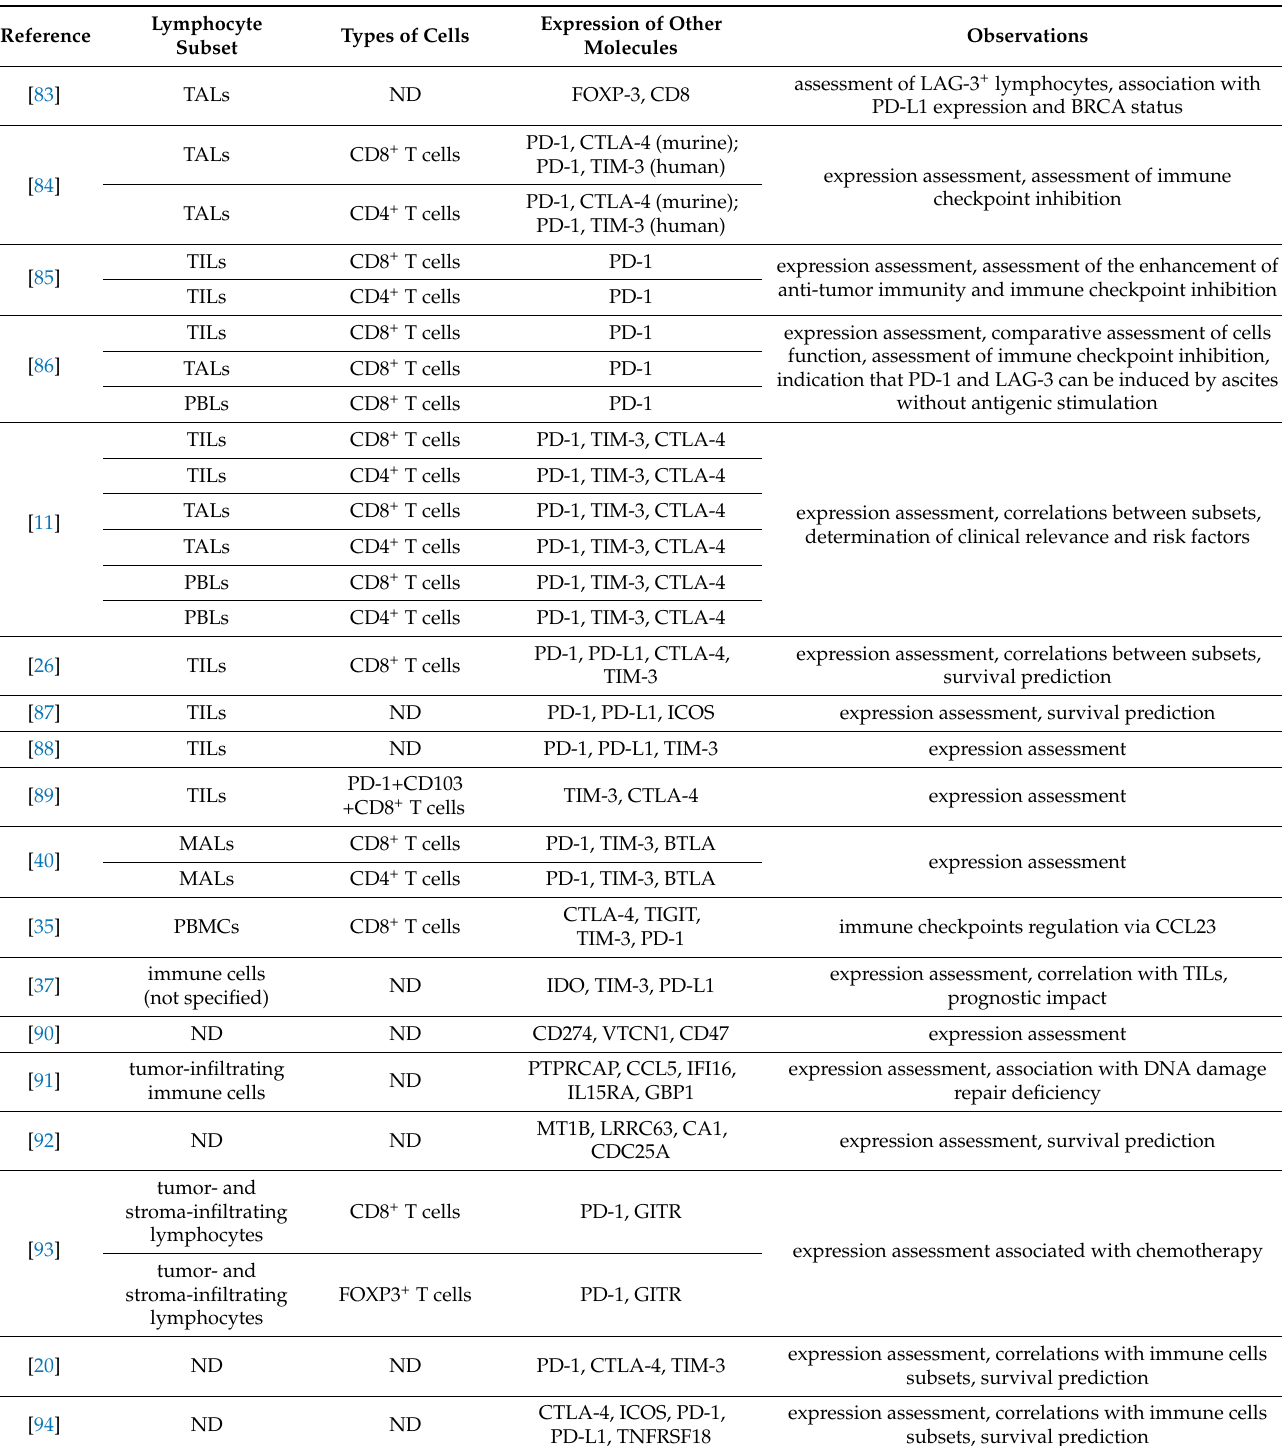
Table 3. LAG-3 expression on tumor-associated immune cells and study observations related to expression.